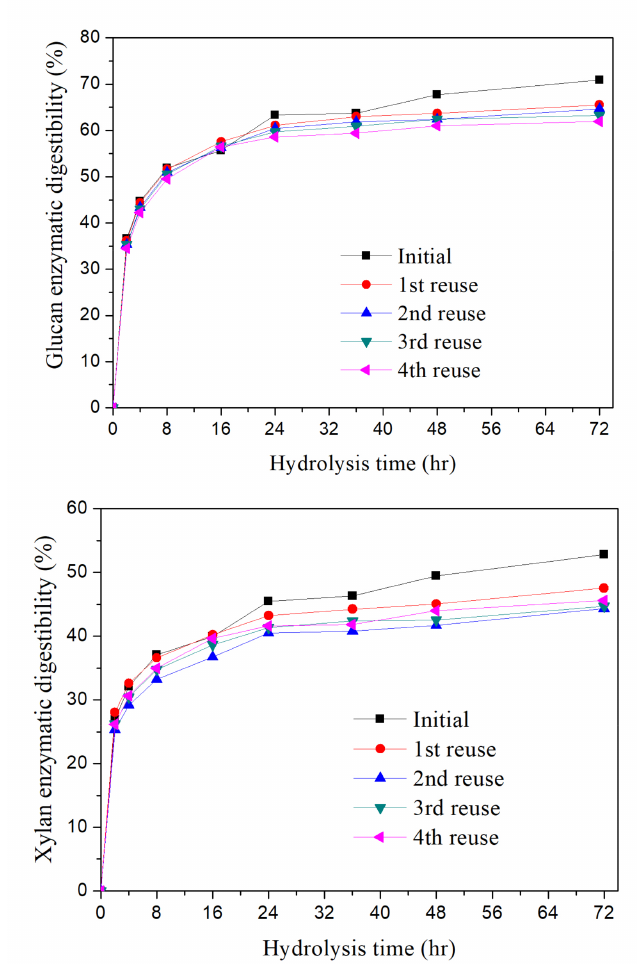
Figure 3. Enzymatic digestibility of pretreated corn stover by reused